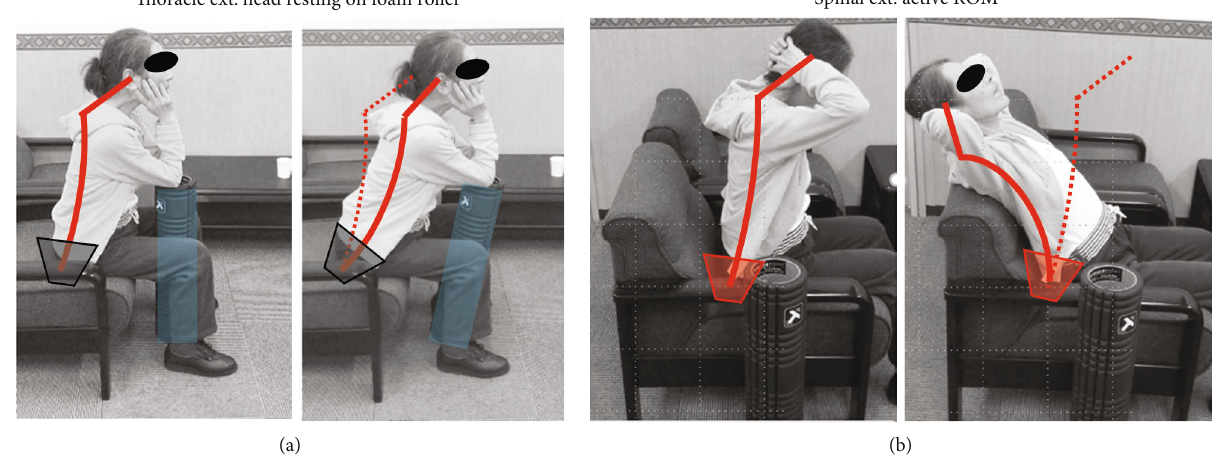
Figure 6: Representative exercises of our AR-PT (phase III) for the present patient. (a) Thoracic extension with head resting on a foam roller. The goal of this exercise was to mobilize and control the cervical and upper thoracic regions while her head was stabilized. The lower thoracic and lumber regions also were consciously controlled with anterior pelvic tilting so that the desired sitting position was under the patient ’ s own control. This exercise corresponded to the phase III ➁➂➃ programs. (b) Spinal extension within the submaximal active range of motion. The goal of this exercise was to activate cervical and upper thoracic regions while her head was stabilized under her own control. Both suboccipital fl exion and pelvic anterior tilt were controlled throughout this movement. This exercise corresponded to the phase III ➀➁➂